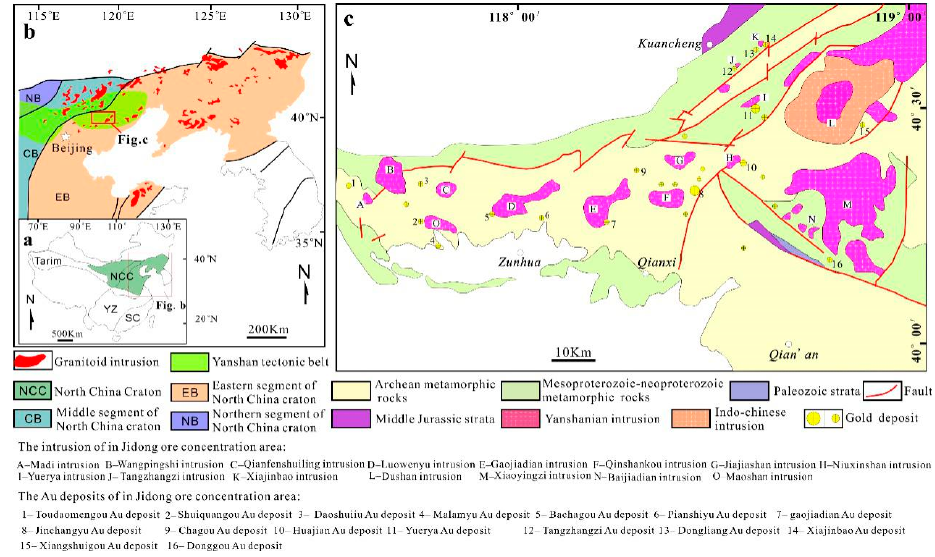
Figure 1. Simplified geological maps: ( a ) Major tectonic divisions of China; ( b ) Sketch map showing the distribution of the Triassic to Jurassic granitic intrusions in the eastern NCC; ( c ) Simplified geological map of the eastern Hebei Province (Modified from Mei [4] and Song et al. [5]).